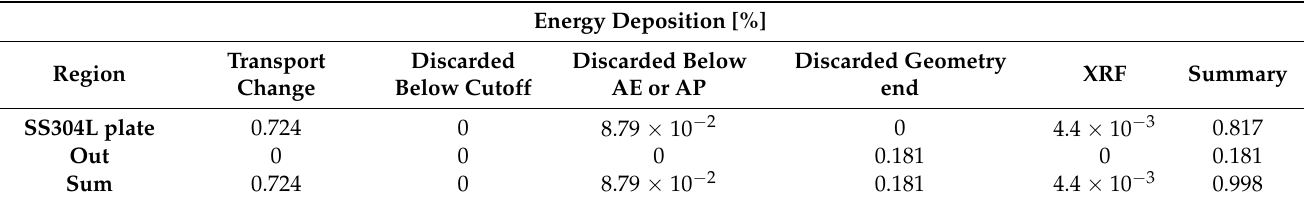
Table 1. Energy deposition – percentage of total energy fluence per incidence electron, output from the Monte Carlo (MC) code. (AE and AP are lower electron and photon cutoff energy).